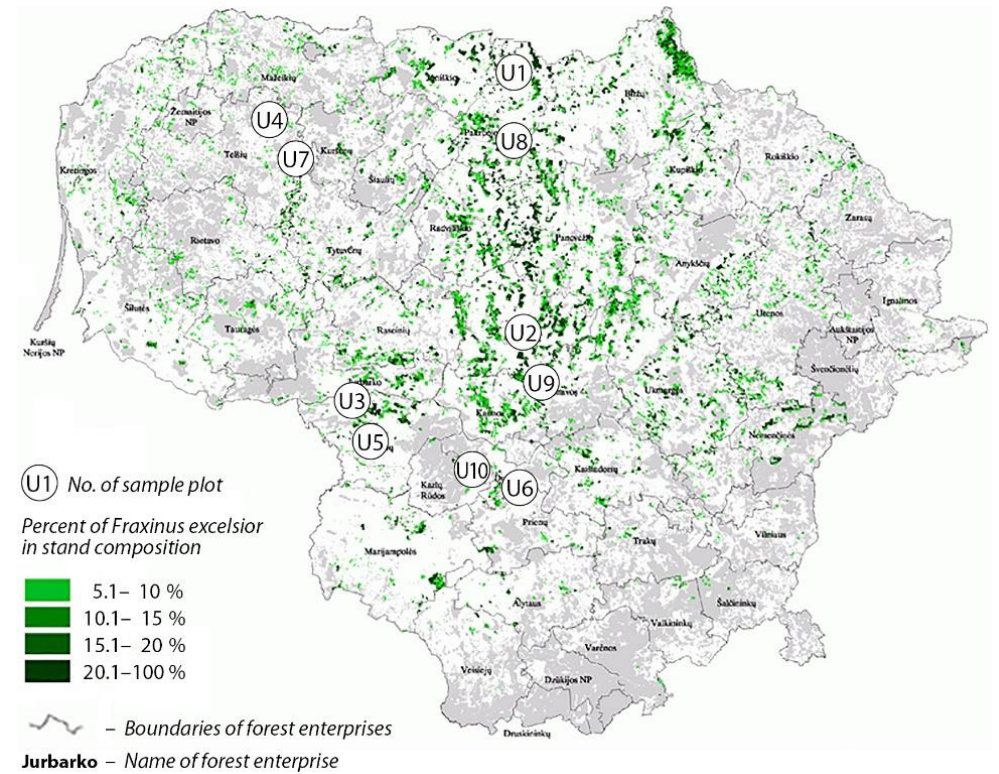
Figure 1. Map of Lithuania showing the distribution of Fraxinus excelsior forest stands (in green), and the position of sampling sites (U1 – U10). Table 1. Fraxinus excelsior sites in Lithuania used in the present study.